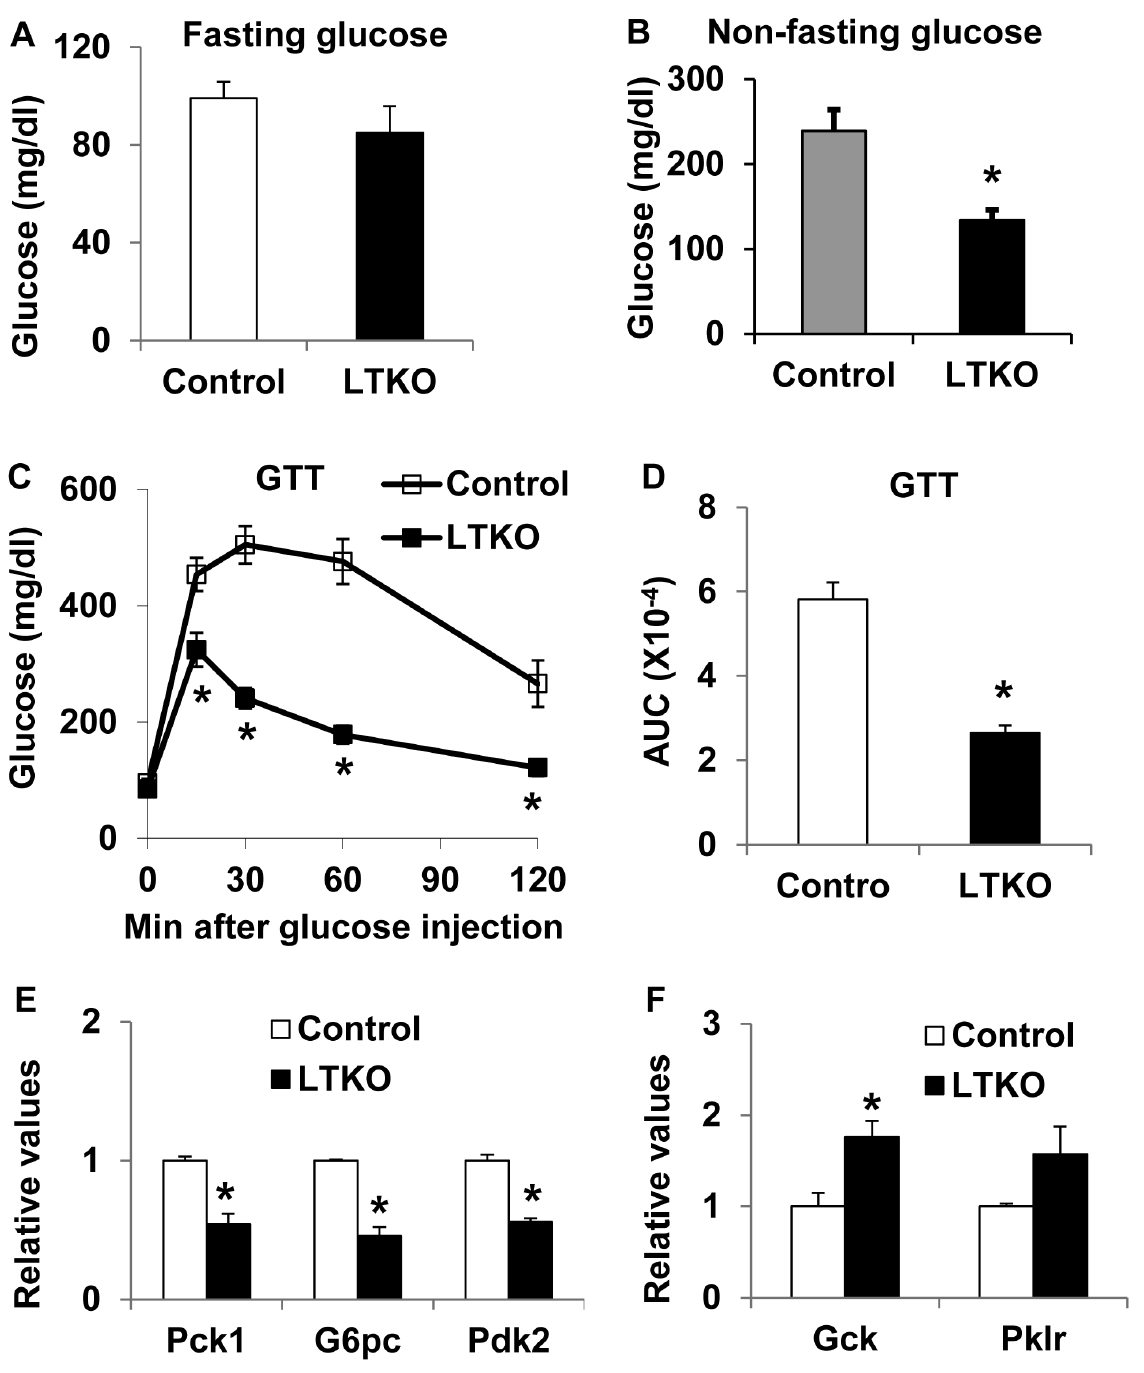
Figure 4. LTKO mice maintain euglycemic and glucose tolerant on a high-fat diet. (A) Fasting glucose levels in 4.5-month male control and LTKO mice (n=8) after the treatment with a high-fat diet for 3.5 months. (B) Non-fasting blood glucose levels in 4- month male control and LTKO mice (n=8) after the treatment with the high-fat diet for 3 months. (C, D) Glucose tolerance tests and the AUC analysis in 4.5-month male control and LTKO mice (n=8) after the treatment with the high-fat diet for 3.5 months, respectively. (E, F) Expression of genes involved in glucose metabolism was analyzed in the liver of control and LTKO mice (n=4) treated with the high-fat diet for 5 months by real-time PCR. Pck1 , phosphoenoylpyruvate carboxykinase 1; G6pc , glucose-6- phosphatase, catalytic; Pdk2 , pyruvate dehydrogenase kinase 2; Gck , glucokinase; Pklr , pyruvate kinase, liver and red blood cell type. Data represent mean ± SEM. * indicates a significance with P <0.05 in control vs. LTKO mice. doi: 10.1371/journal.pone.0074340.g004 PLOS ONE |